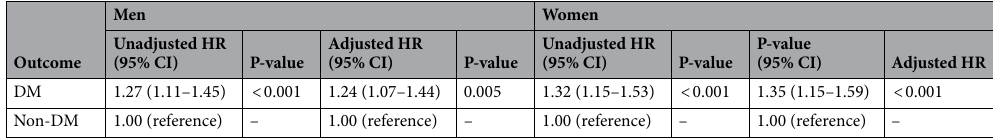
Table 3. Association of diabetes mellitus with the 5-year mortality in men and women with heart failure. CI = confidence interval; DM = diabetes mellitus; HR = hazard ratio.